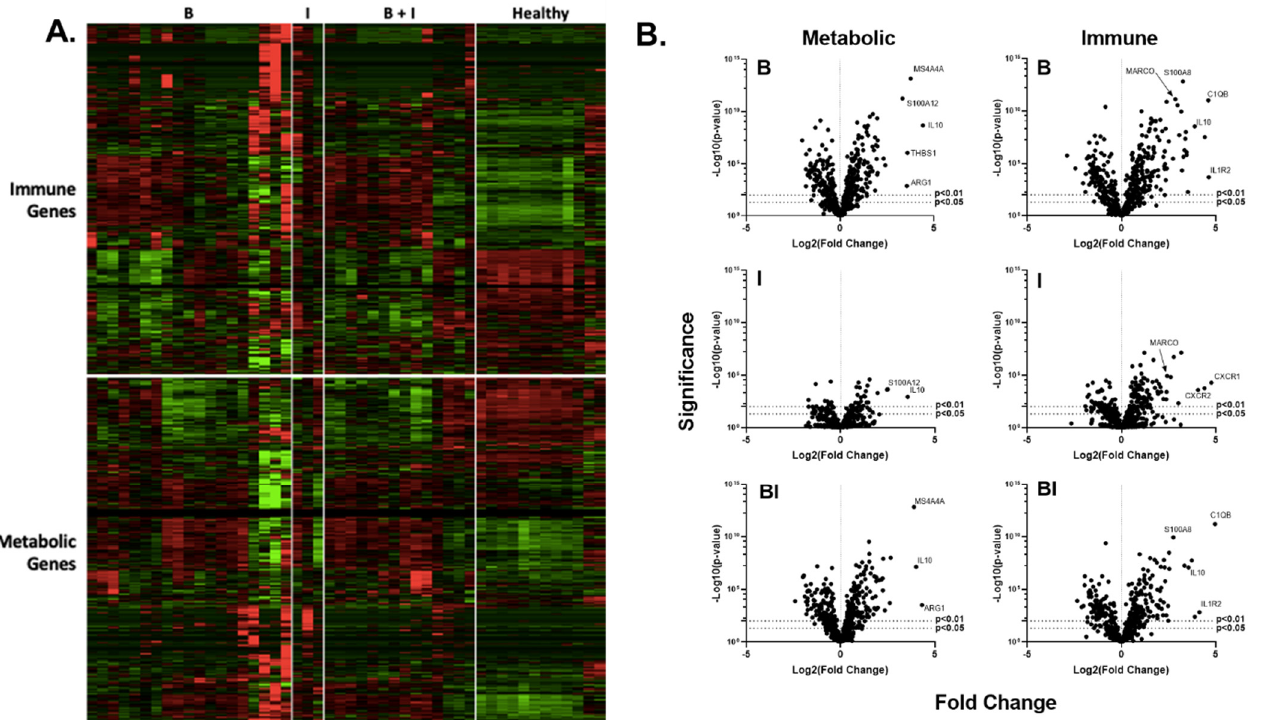
Figure 2. Burn injury, inhalation, and BI injuries induce changes in PBMC gene expression profiles. mRNA was isolated from PBMC, which was isolated from burn patients or healthy controls, and gene expression was evaluated using nanostring barcoding (nCounter Human Immune Profiling PanCancer CodeSet; 770 genes, and the Human Metabolic Gene CodeSet; 768 genes). Data are presented ( A ) as a heat map clustered hierarchically (green, downregulated; red, upregulated) and ( B ) as the log2-transformed differential fold change in metabolic and immune gene expression with associated p -value significance (using Welch’s t -test) after data normalization to housekeeping and internal control genes with nSolver